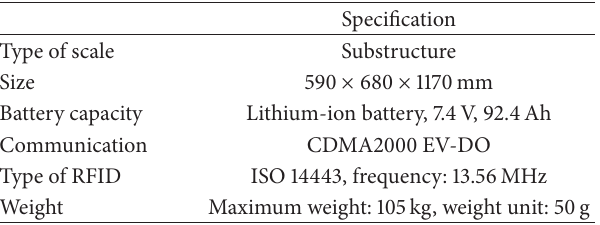
Table 2: Specifications of a smart garbage